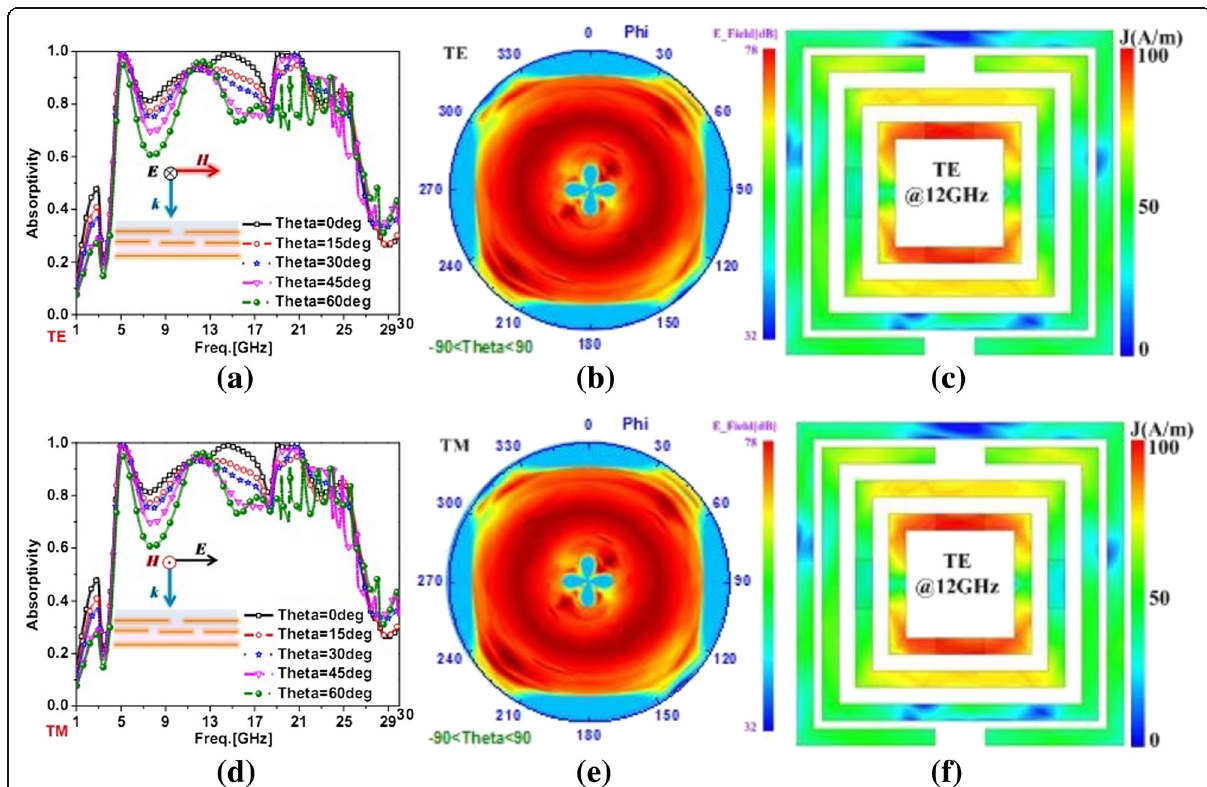
Fig. 6 The absorption results, surface current distributions and near electric fields of the present ultra-broadband PMA with different polarized incidences. a The oblique absorption results of the PMA with TE polarized incidences from 1 to 30GHz with theta shifted from 0 to 60°. b . The near electric fields of PMA at 12GHz with TE polarized incidences. c The surface current distributions of PMA at 12GHz with TE polarized incidences. d The oblique absorption results of the PMA with TM polarized incidences from 1 to 30GHz with theta shifted from 0 to 60°. e The surface current distributions of PMA at 12GHz with TM polarized incidences. f The near electric fields of PMA at 12GHz with TM polarized